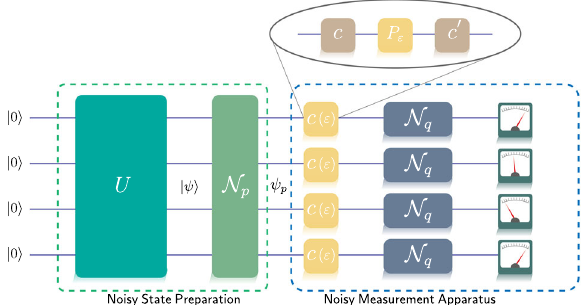
Fig. 1 Schematic of the implementation of the experiment for measuring magic on a quantum processor. From left to right: initialization of the system in the state 0 j i (cid:3) n ; preparation of the target state ψ j i by a unitary quantum circuit U t containing a number t of non-Clifford gates; intervention of the noise N p affecting the system effectively prepares the (mixed) state ψ p ; measurement. The measurement apparatus is composed of n local Clifford operators N n C ¼ c i randomly sampled from the single qubit Clifford group i ¼ 1 c i 2 C 1 , followed by n measurements in the computational basis f s j ig that are performed to estimate the occupation probabilities P ( C ψ C † ∣ s ). The gate imperfection in the application of the Clifford operators is denoted by c ( ϵ